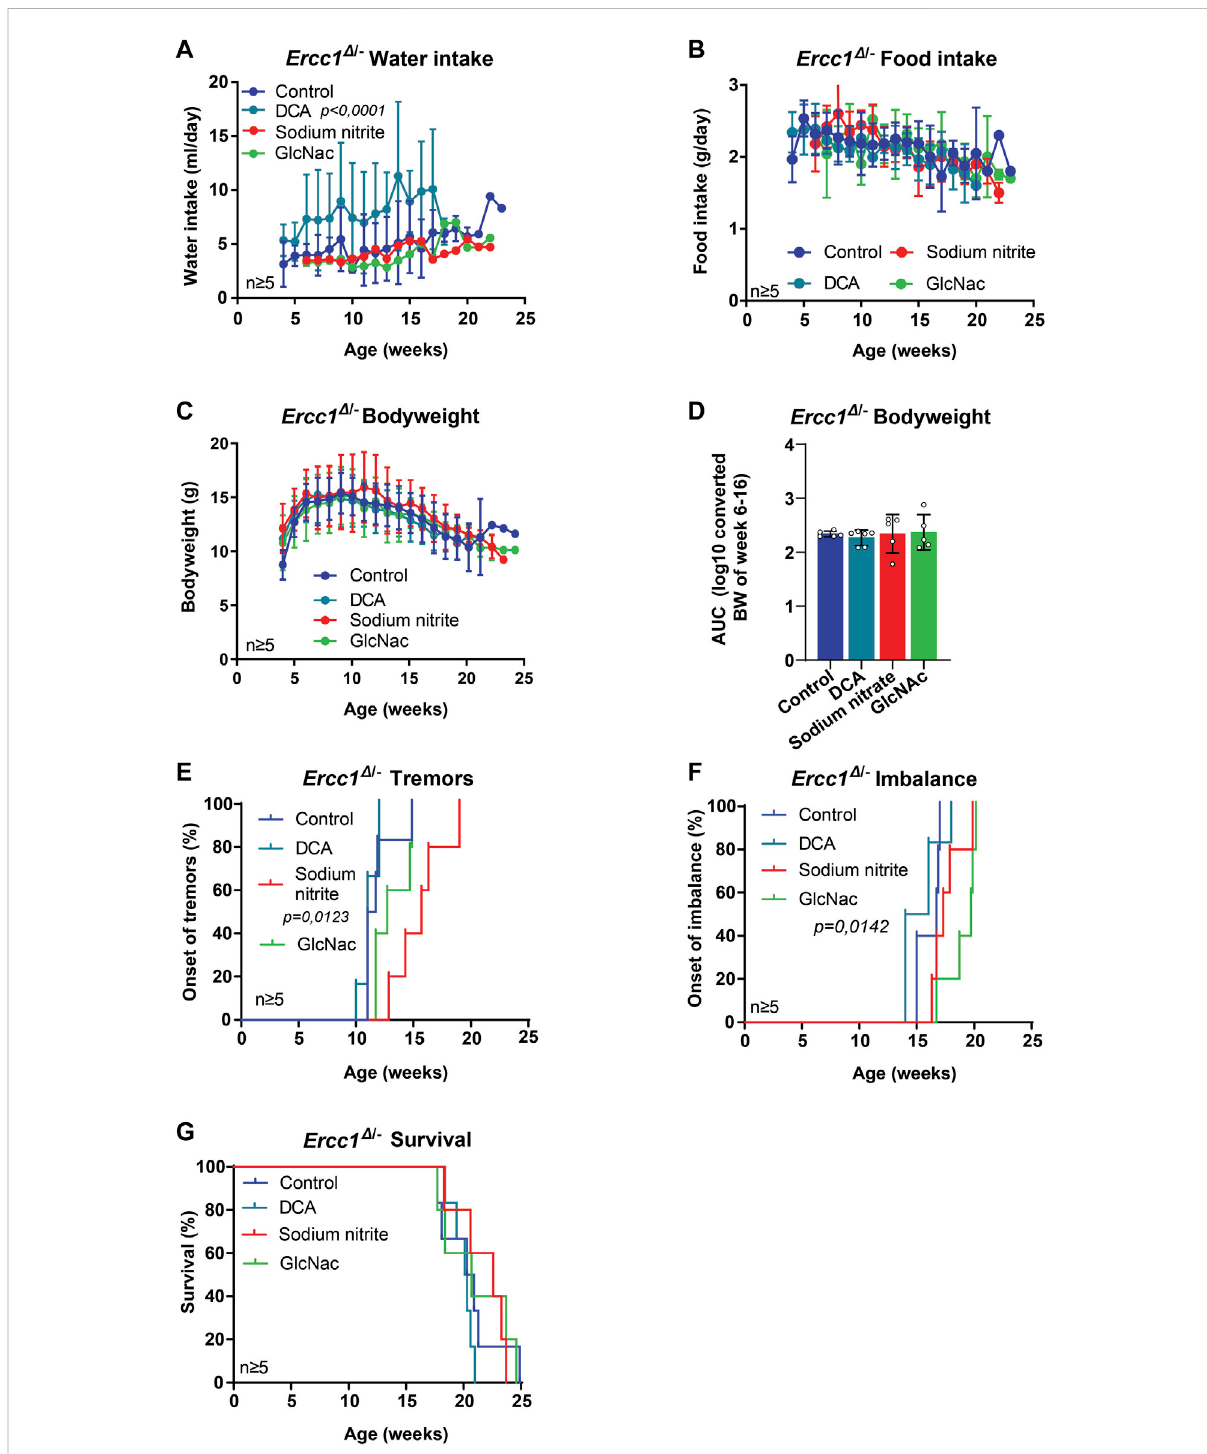
FIGURE 2 The effect of mitochondrial modi fi ers and GlcNAc supplementation on the lifespan and onset of neurological phenotypes of Ercc1 Δ / − mice. (A – D) , Comparison between Ercc1 Δ / − control mice and animals supplemented with sodium nitrite, DCA, or GlcNAc on water intake (A) , food intake (B) , bodyweight over time (C) and body weight as area under the curve (AUC) of measurements between 6 – 16 weeks (D) . (E – G) , Onset of neurological abnormalities; tremors (E) and imbalance (F) , and survival (G) of the same animals. Indicated values are Mean (±SD). Signi fi cant p values of the Dunnet ’ s multiple comparison test (A,E,F) are